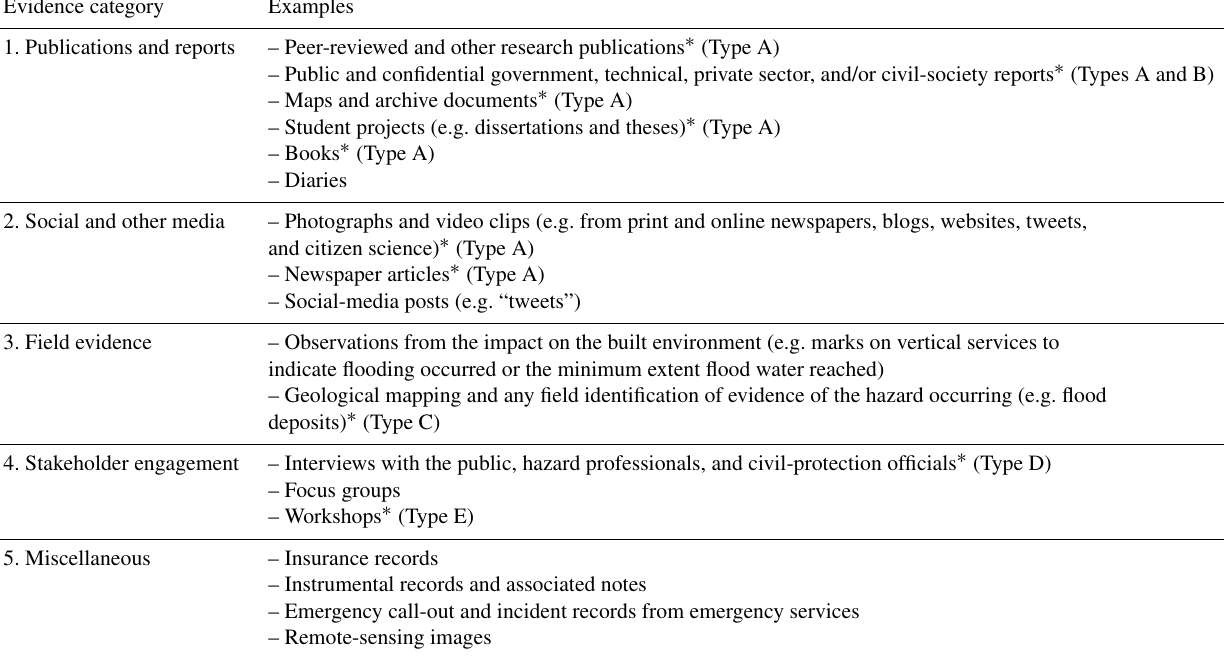
Table 2. Examples of five diverse evidence categories with examples for each one that might indicate the relevance of a given multi-hazard interaction. We use an asterisk ( ∗ ) to indicate the examples of evidence that are used in this paper (grouped into evidence types A to E; see Sect.